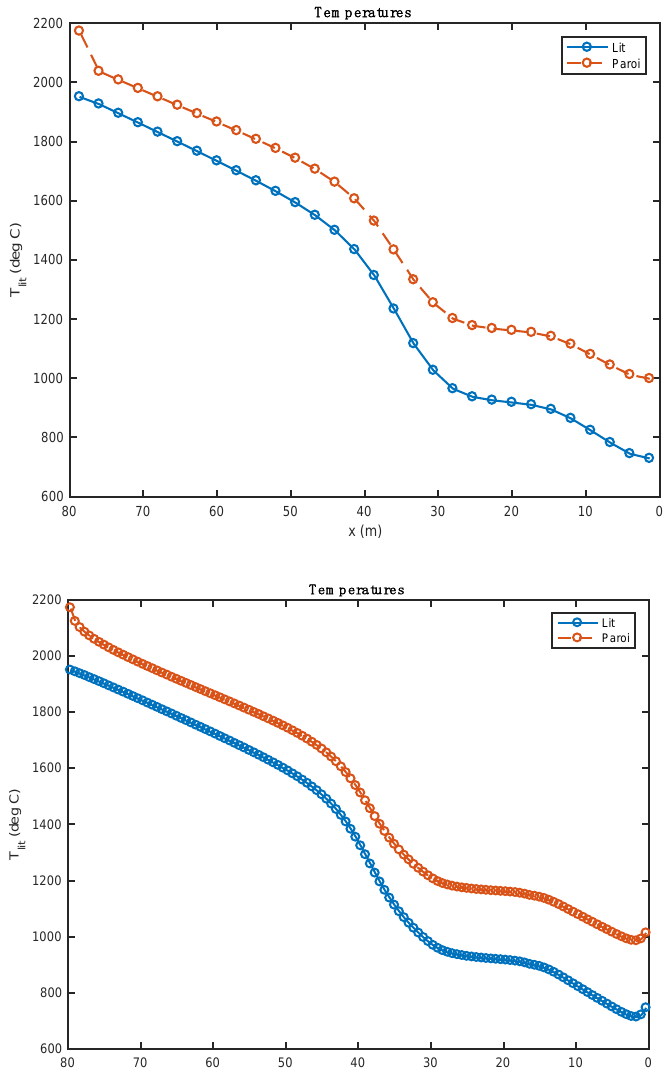
Figure 6. Comparison of the temperature profiles obtained with 30 (above) et 120 (below) compute nodes (heavy fuel oil and biomass).